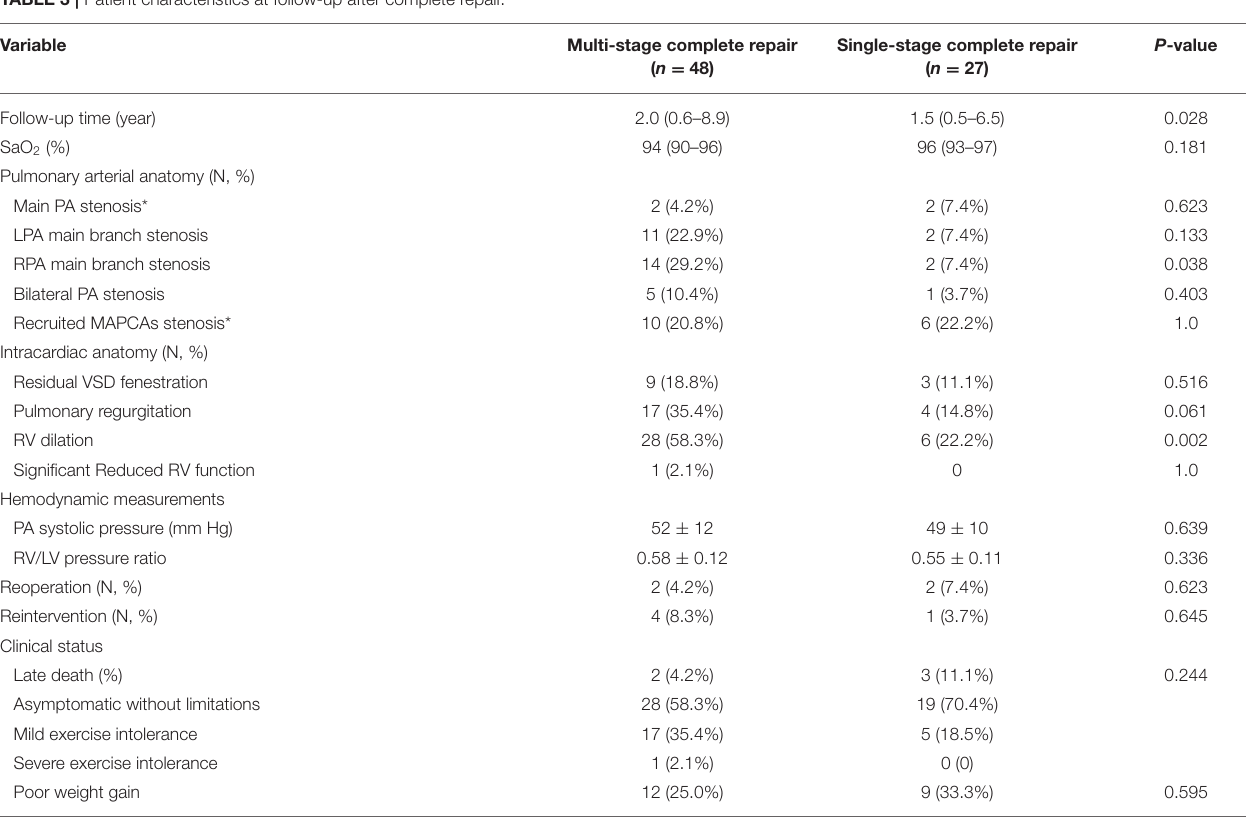
TABLE 3 | Patient characteristics at follow-up after complete